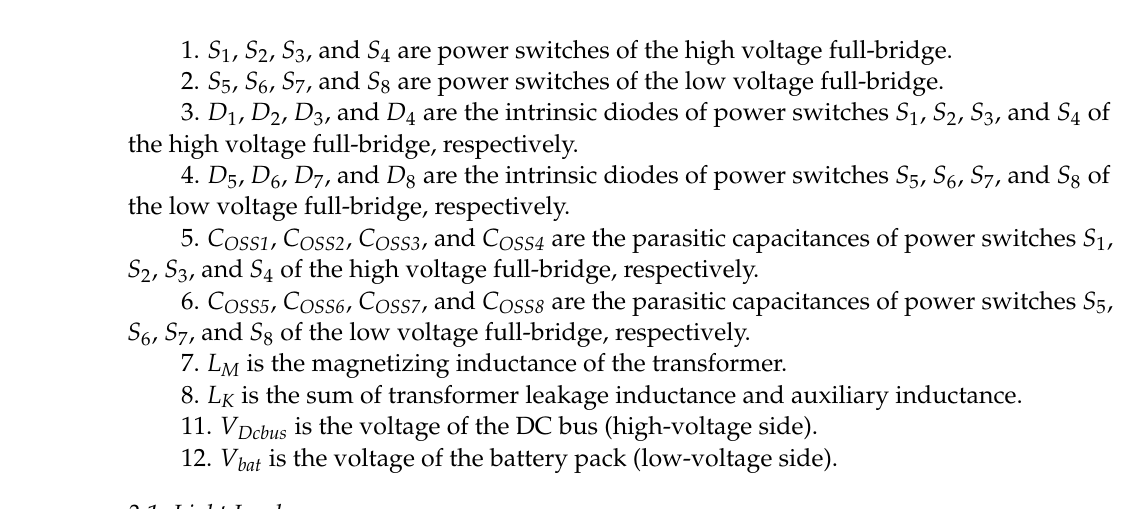
Figure 4. Circuit structure of the DAB converter.